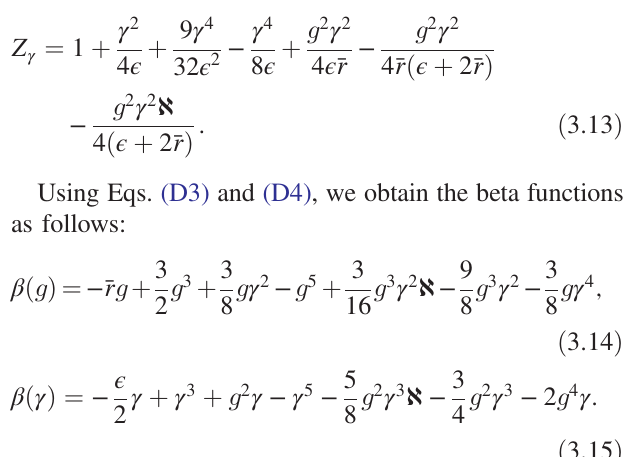
FIG. 3. One-loop RG flow in the g − γ plane plotted for ϵ ¼ 1 and ¯ r ¼ 0 . 5 . The red point is the stable fixed point ( FP 4 ) and green points are the saddle ( FP 2 and FP 3 ) and the blue point is the unstable Gaussian fixed point ( FP 1 ). Note that the flow in the s direction is always relevant (not